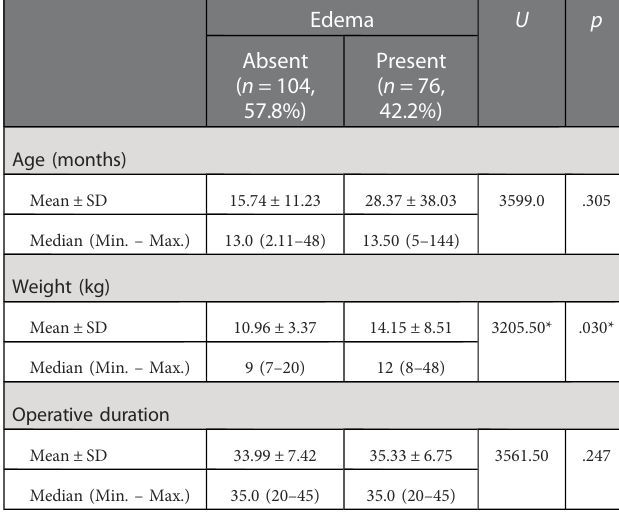
TABLE 2 Relation between edema with different parameters for the total sample ( n =180). Edema